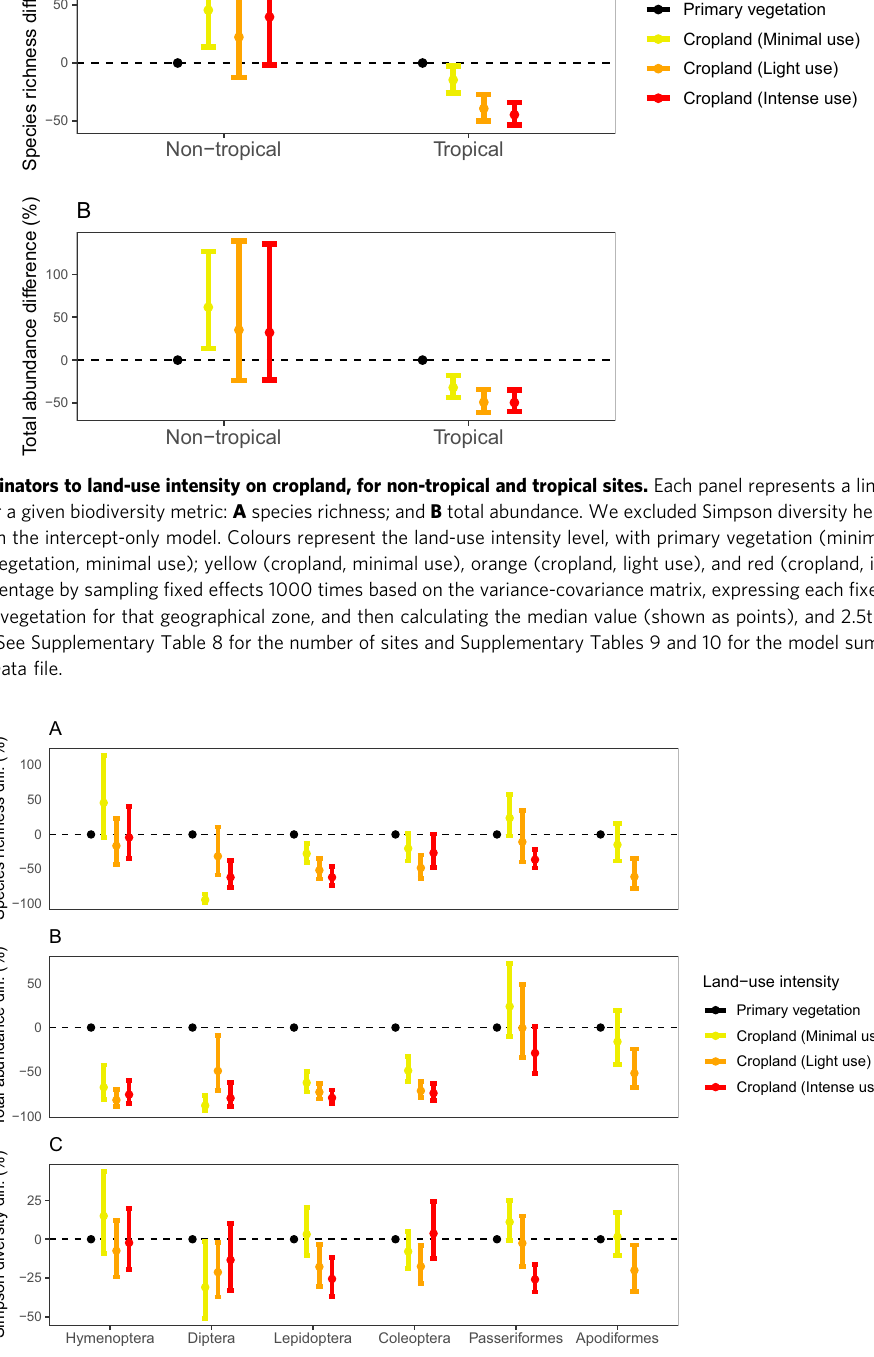
Fig. 4 Response of different pollinator groups to land-use intensity in cropland. Each panel represents a linear or generalised linear mixed-effects model for a given biodiversity metric: A species richness; B total abundance; and C Simpson diversity. Colours represent the land-use intensity level, with primary vegetation (minimal use) as a reference factor: black (primary vegetation, minimal use); yellow (cropland, minimal use), orange (cropland, light use), and red (cropland, intense use). Effect sizes were adjusted to a percentage by sampling fi xed effects 1000 times based on the variance-covariance matrix, expressing each fi xed effect within each random sample as a percentage of the value in primary vegetation for that taxonomic order, and then calculating the median value (shown as points), and 2.5th and 97.5th percentiles (shown as error bars). See Supplementary Table 11 for the number of sites and Supplementary Tables 12, 13, and 14 for the model summaries. Source data are provided as a Source Data fi